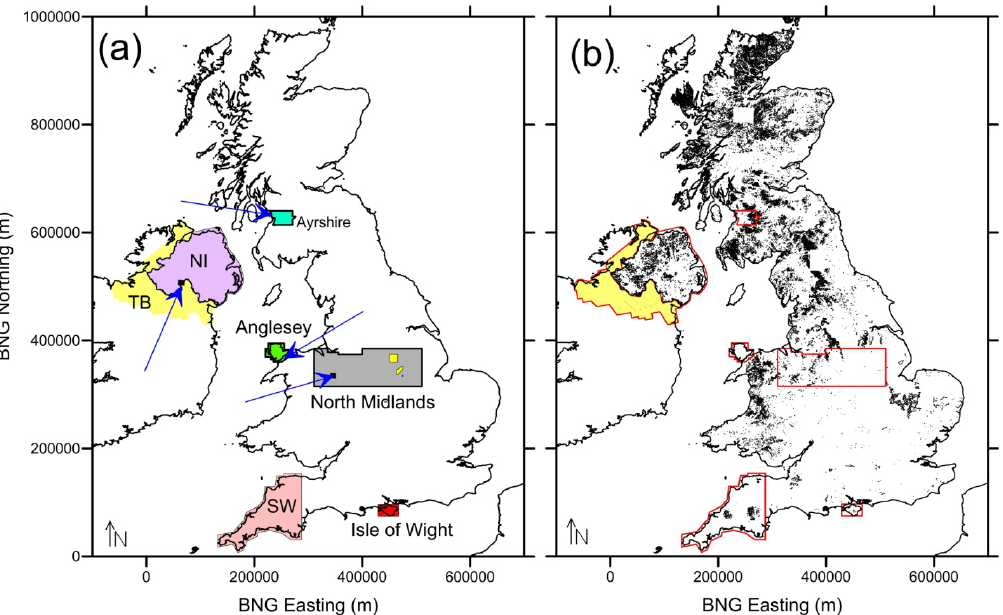
Figure 1. ( a ) HiRES airborne geophysical surveys in the UK (2008–2013), coloured areas. The recent survey in the Republic of Ireland is labeled (TB, Tellus Border). Arrows denote the four areas studied here. ( b ) The airborne survey areas (red polygons) overlaid on the DiGMAPGB50 UK mapping of peat (onshore black contours). BNG refers to British National